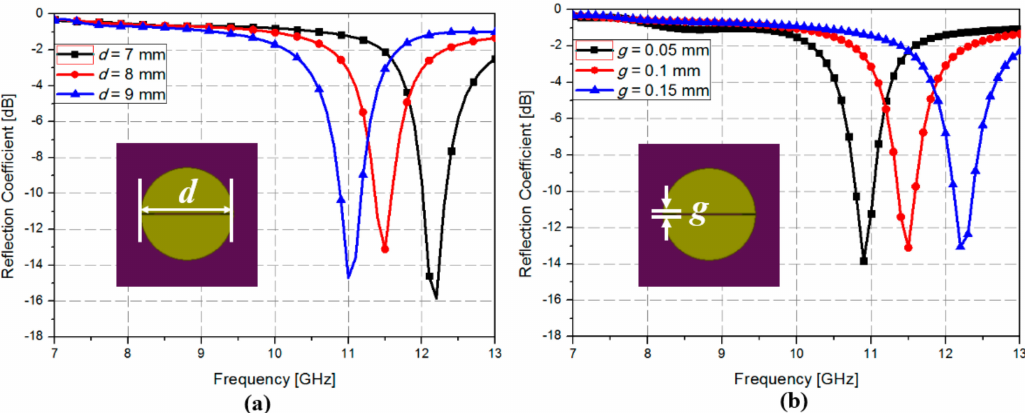
Figure 2. Simulated reflection coefficients without GeTe film when ( a ) d is varied from 7 to 9 mm with g = 0.1 mm ( b ) g is varied from 0.05 to 0.15 mm with d = 8